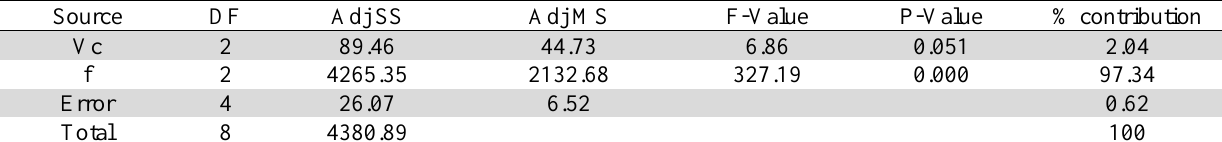
Analysis of variance for cutting force (Fc)